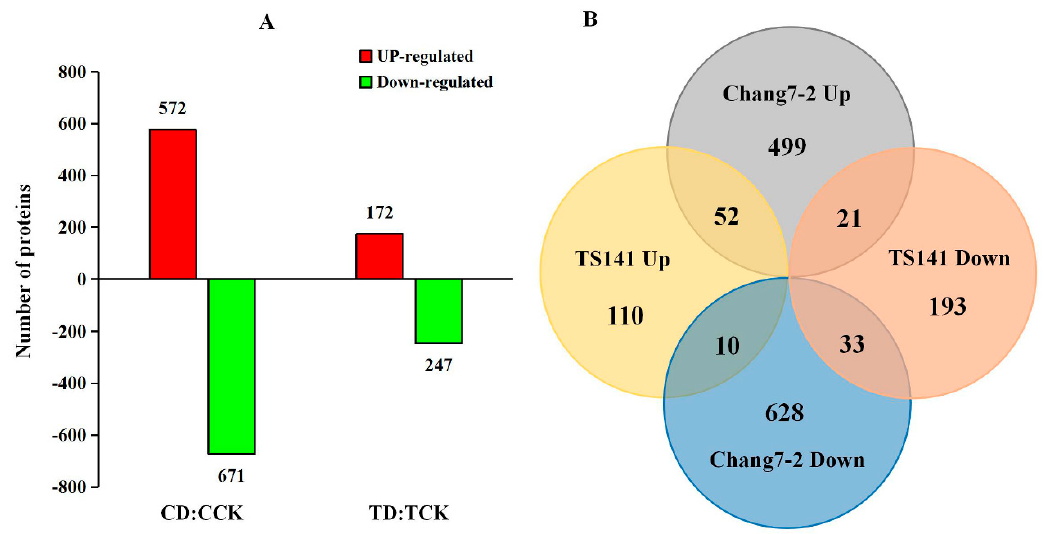
Figure 5. ( A ) Number of up-regulated and down-regulated proteins. ( B ) Venn diagram of the two maize varieties.